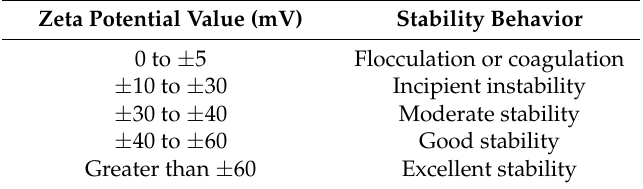
Table 1. Stability behavior of colloids based on zeta potential values [145].